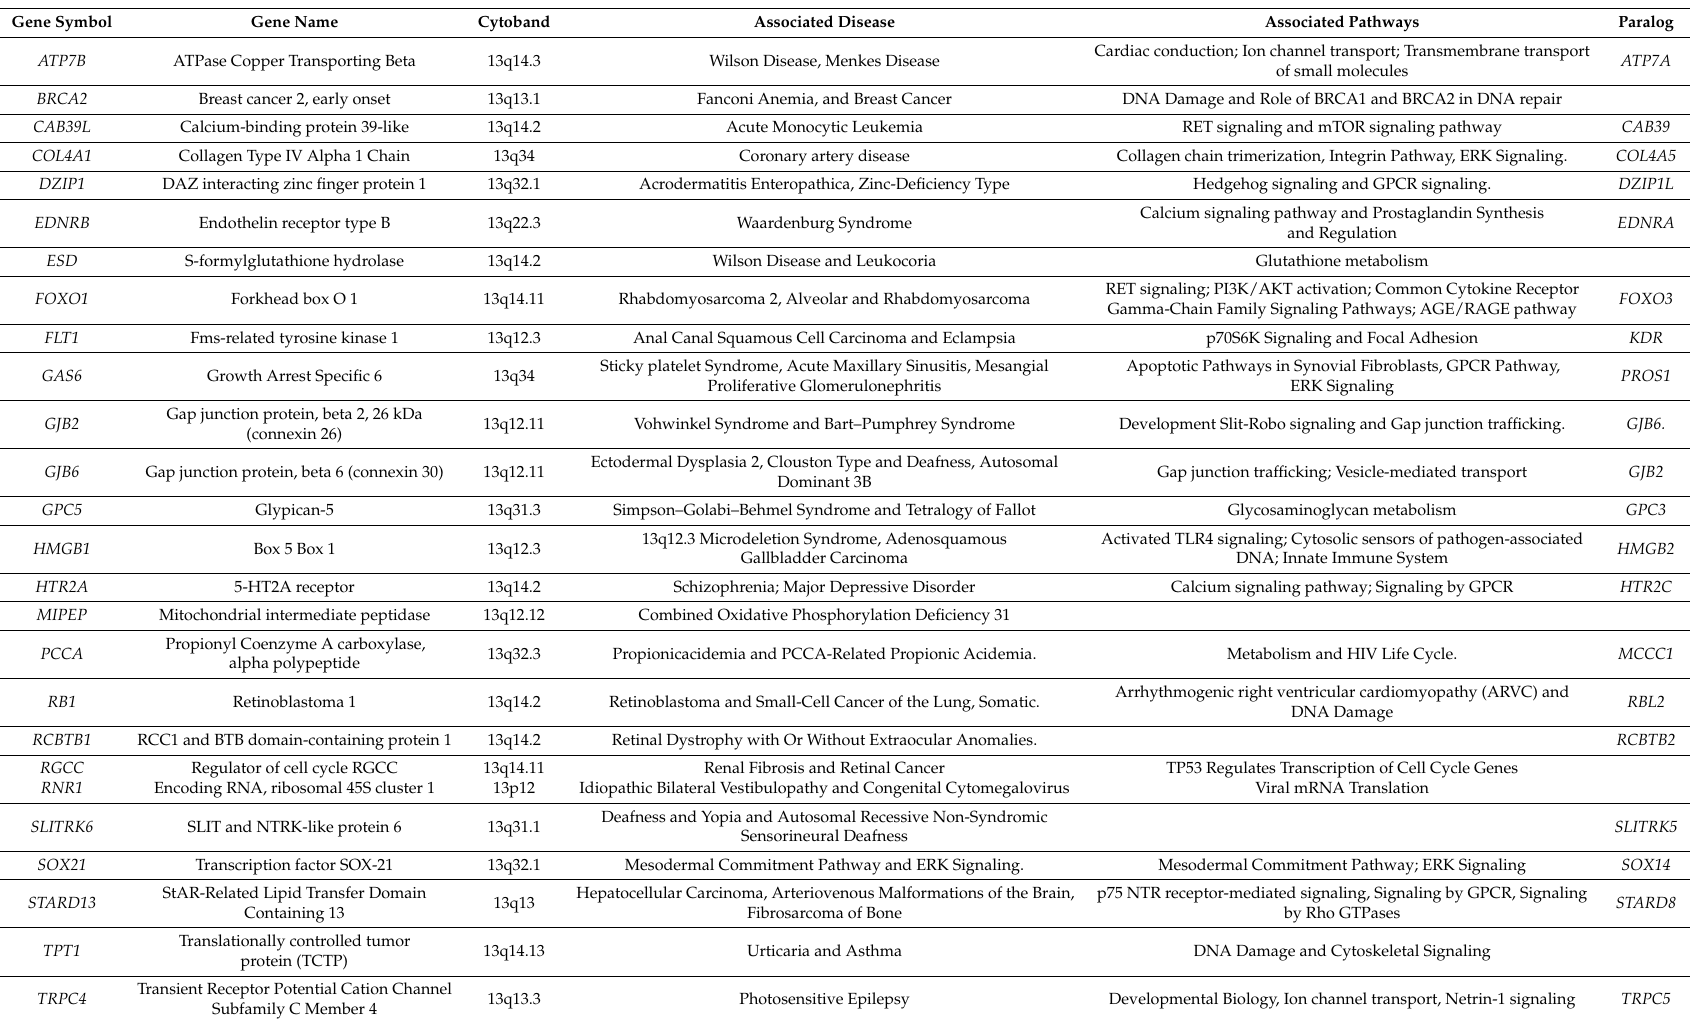
Table 1. Important pathogenic genes located on chromosome